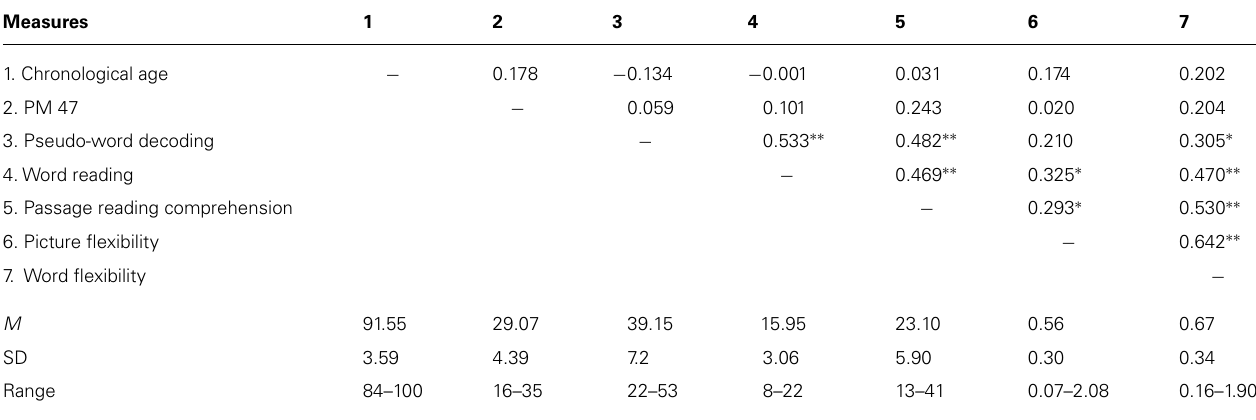
Table 1 | Pearson product-moment correlations, means, standard deviations and range for age, PM47 (raw scores), pseudo-word decoding, word reading, passage reading comprehension, picture and word flexibility scores ( N = 60). Measures